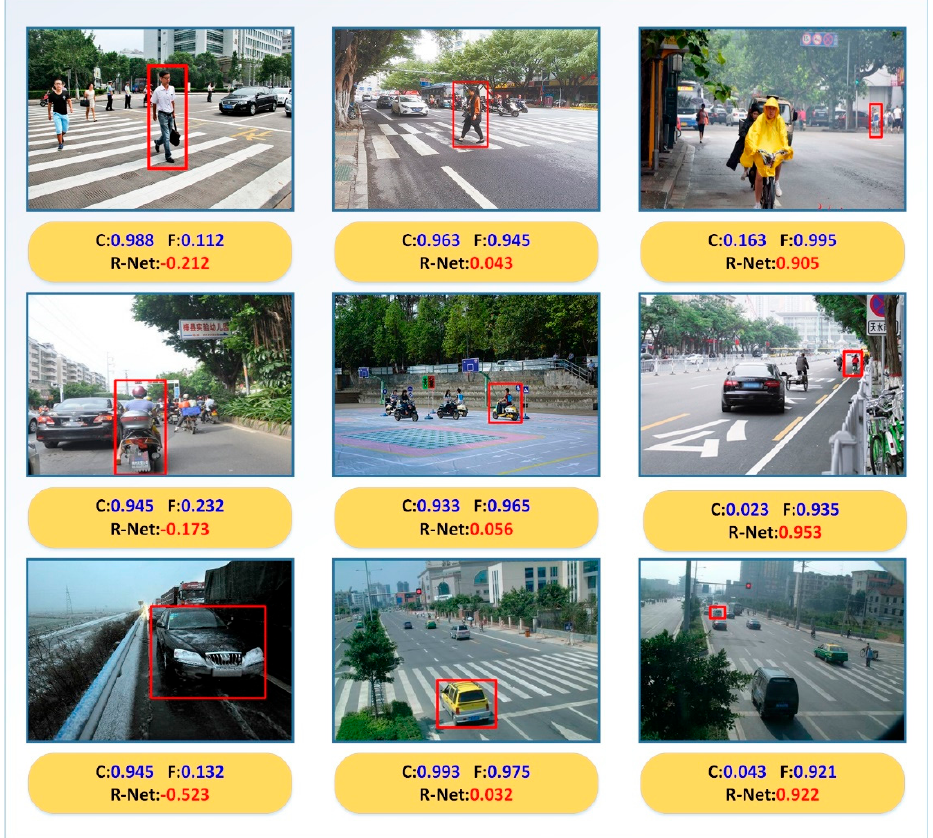
Figure 13. R-net amplification precision gain effect.